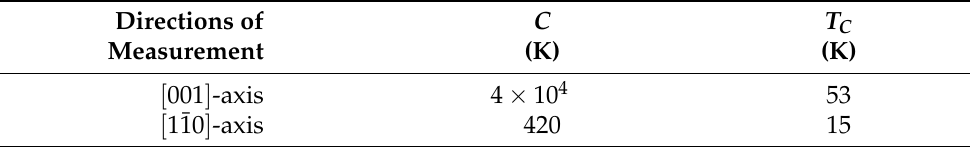
Table 2. Parameters C and T C of λ -(BEDT-STF) 2 GaCl 4 obtained from the fit of (cid:101) (cid:48) ( T ) by the Curie– Weiss Equation (4) for E (cid:107) [ 001 ] and E (cid:107) [ 1¯10 ] . Directions